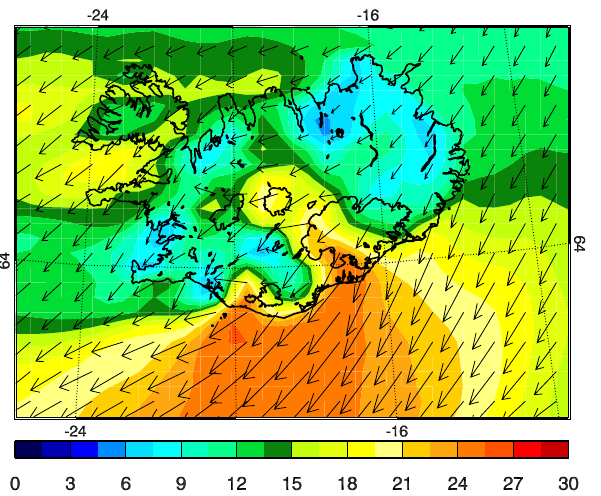
Fig. 1. Wind speed [ms − 1 ] (colored shadings) and wind direction (black arrows) from the WRF/Chem simulation at the lowest model level for G1 on 22 February, 12:00UTC (see Sect. 4.1 for a descrip- tion of the model configuration).